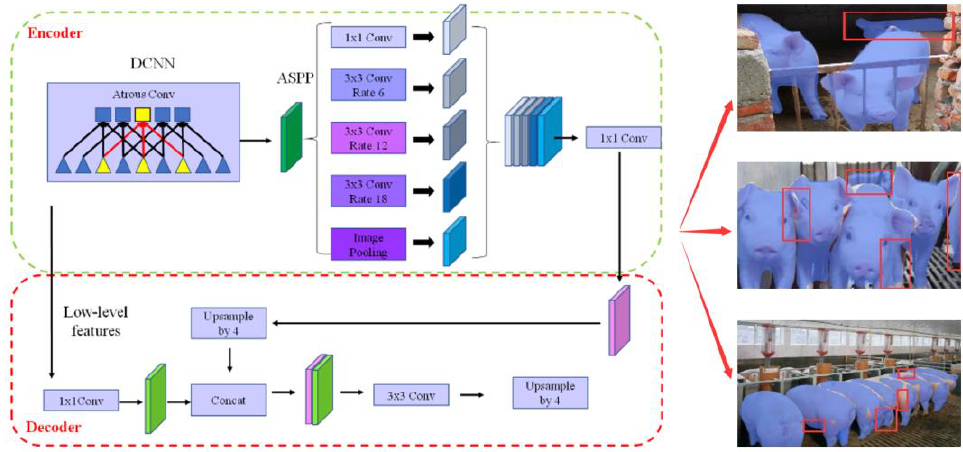
Figure 3. The DeepLab v3+ network structure.